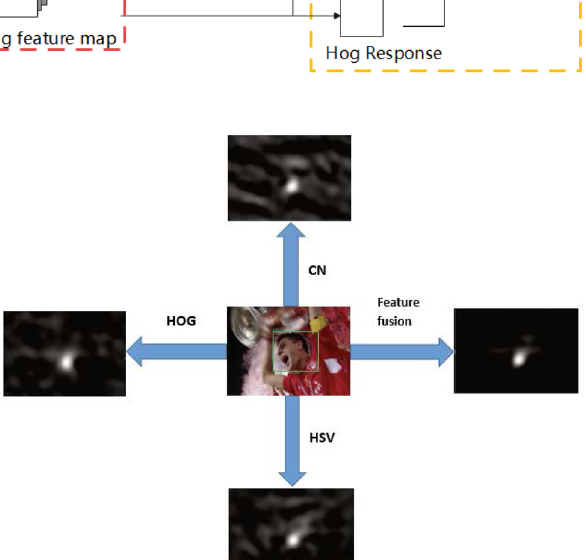
of hidden variables of various parts, this method provides a better tracking effect than the best contemporary linear and nonlinear kernel tracker. Harley et at. [23] propose an unsu- pervised method for detecting and tracking moving objects in 3D, in unlabeled RGB-D videos. The constraint of ensem- ble agreement helps combat contamination of the generated pseudo-labels, and data augmentation helps the modules gen- eralize to yet-unlabeled